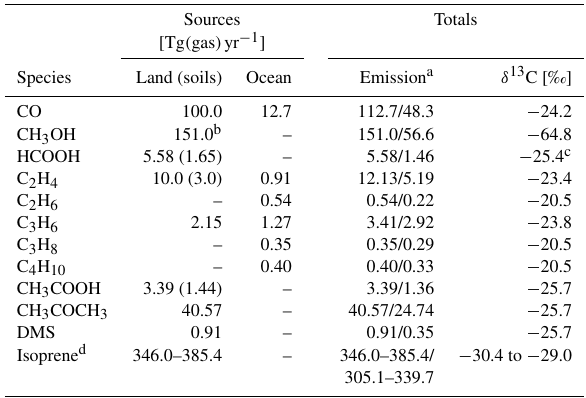
Table 4. Biogenic emission sources strengths and their isotopic sig-